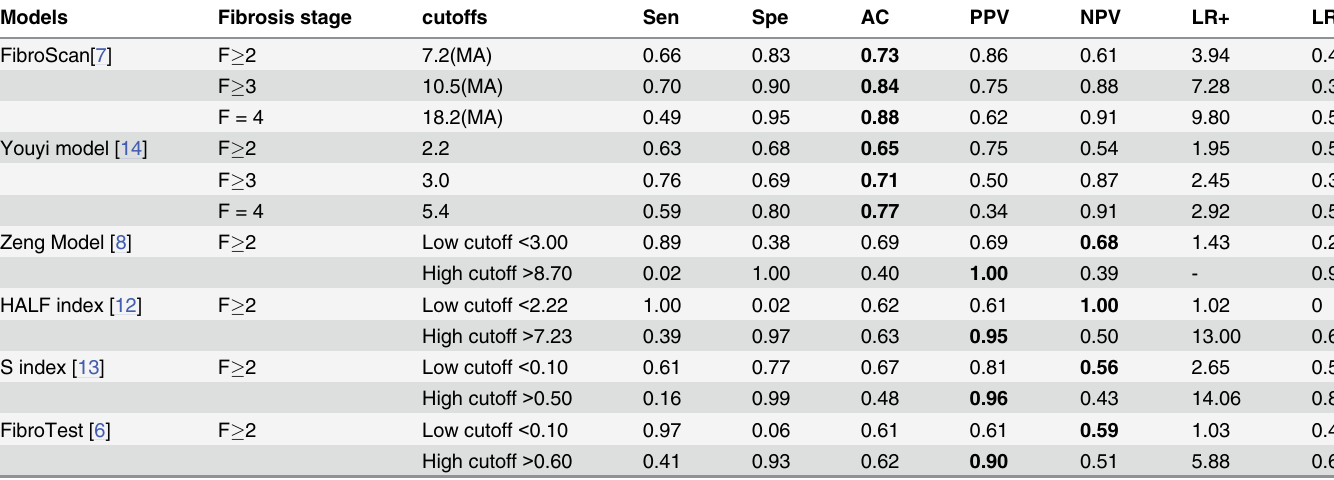
Table 5. Diagnostic values of FibroScan, Youyi model, Zeng model, HALF index, S index and FibroTest with their given cutoff values in predicting liver fibrosis in CHB patients.